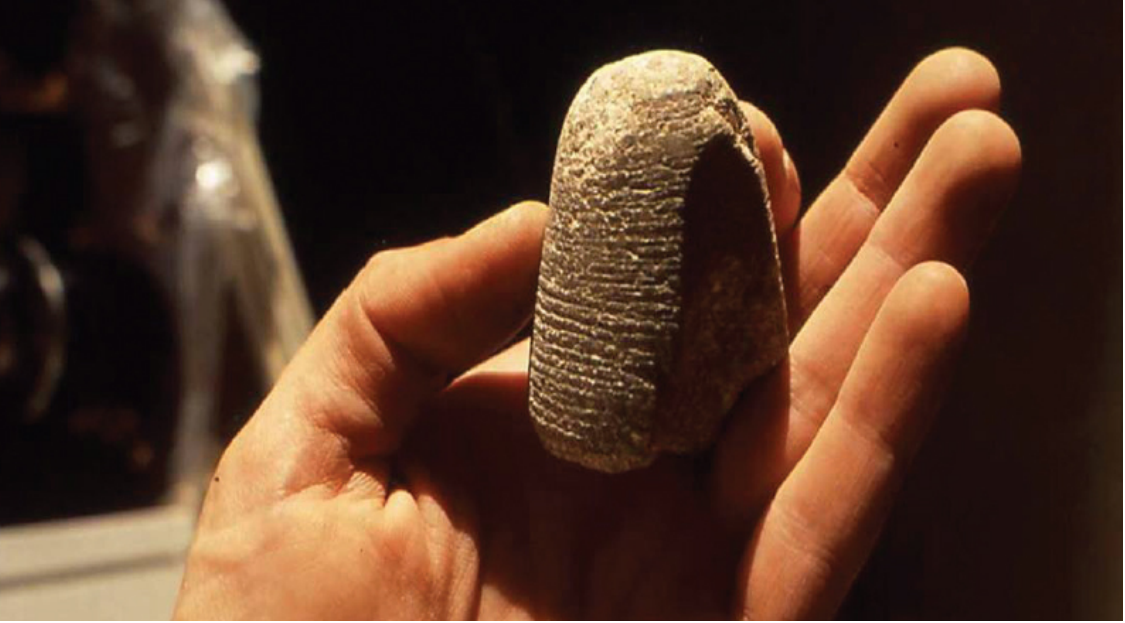
Figure 8. Drill bit of the conical type, from the Lost City of the Pyramids project, Old Kingdom, Giza, Egypt (Tavares 2009:4, courtesy M. Lehner). It is held upside down in the